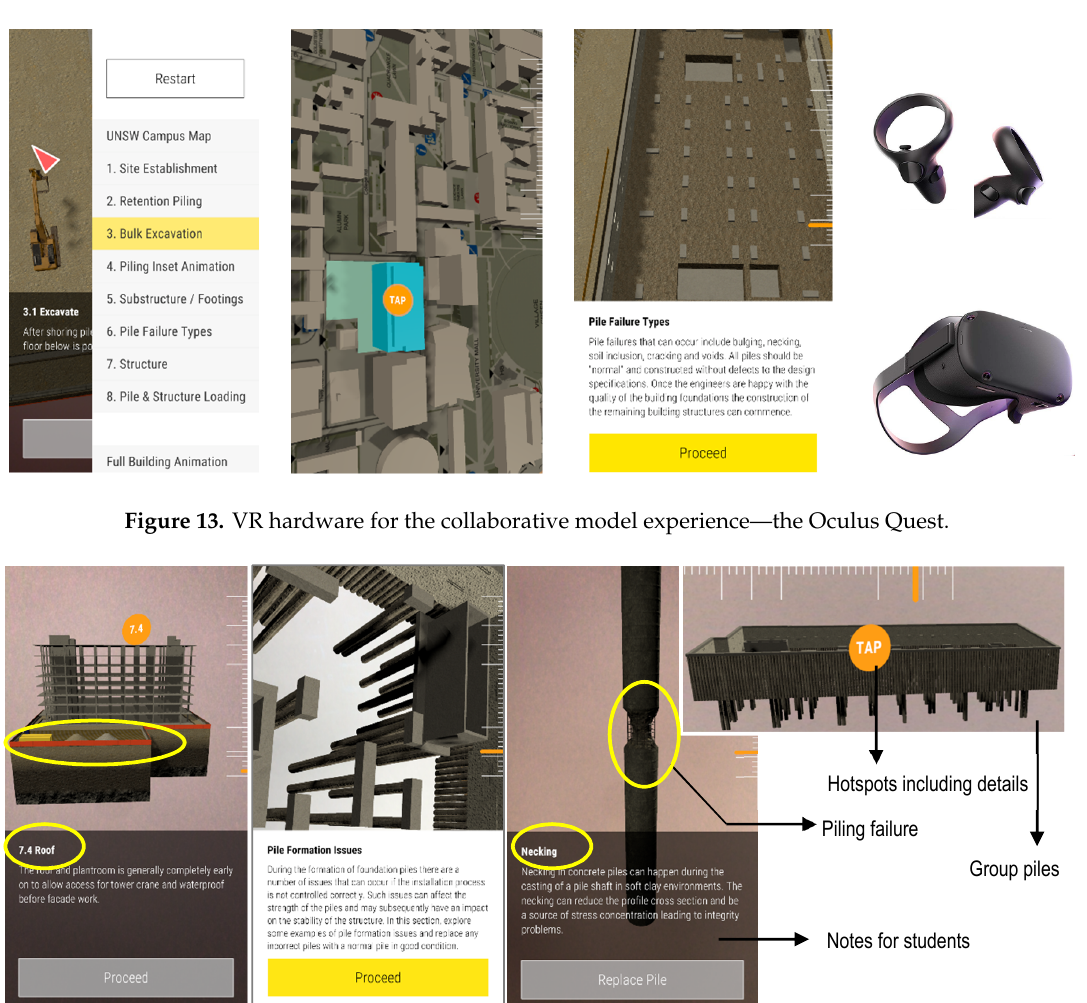
Figure 14. The collaborative model experience is presenting the entire structure and piling systems.